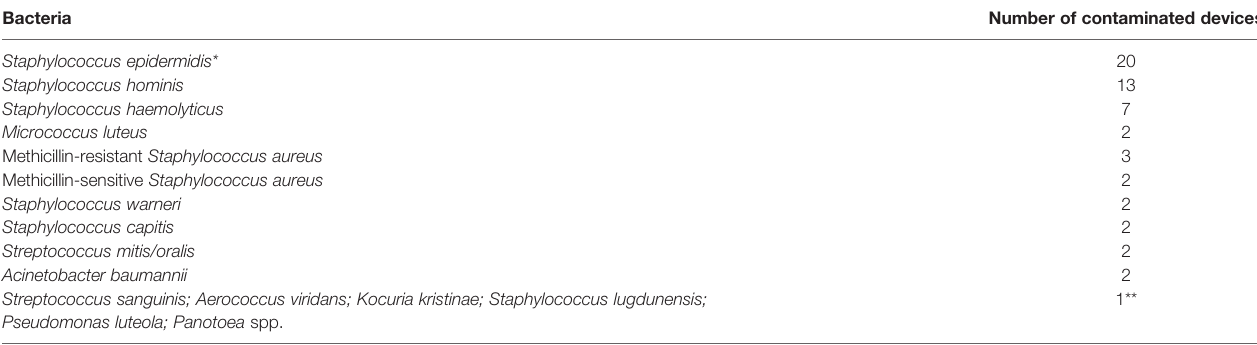
TABLE 2 | Distribution of bacteria isolated from mobile phones and identi fi ed by culture-based methods. Bacteria